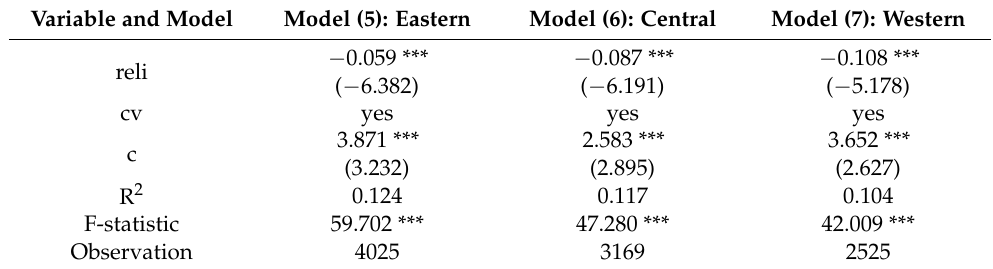
Table 5. Results of heterogeneous